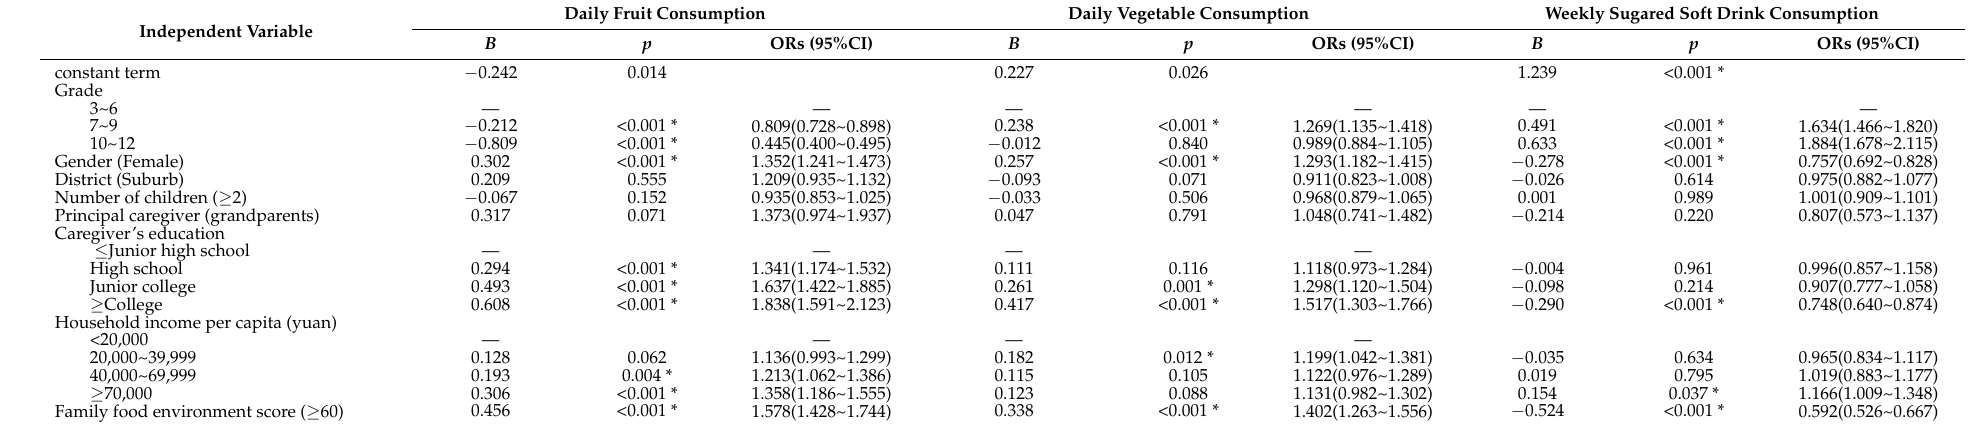
Table 5. Logistic regression analysis of food